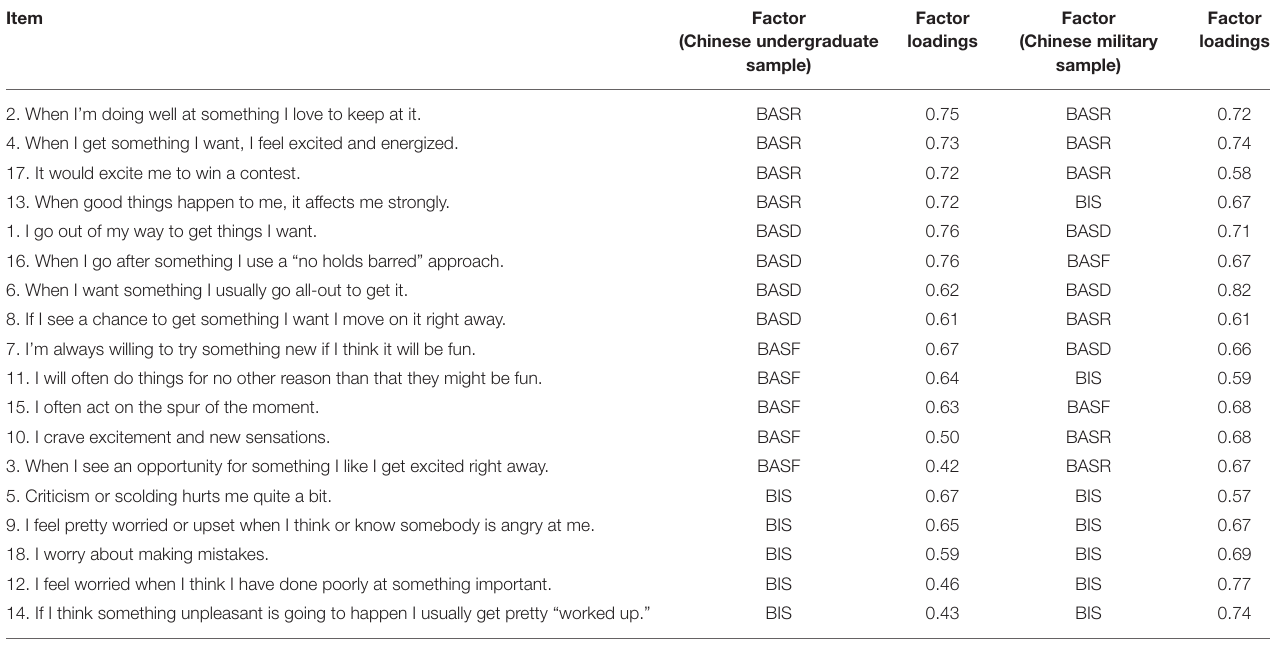
TABLE 3 | Exploratory factorial analysis of Behavioral Activation/Inhibition scales of Chinese military men.